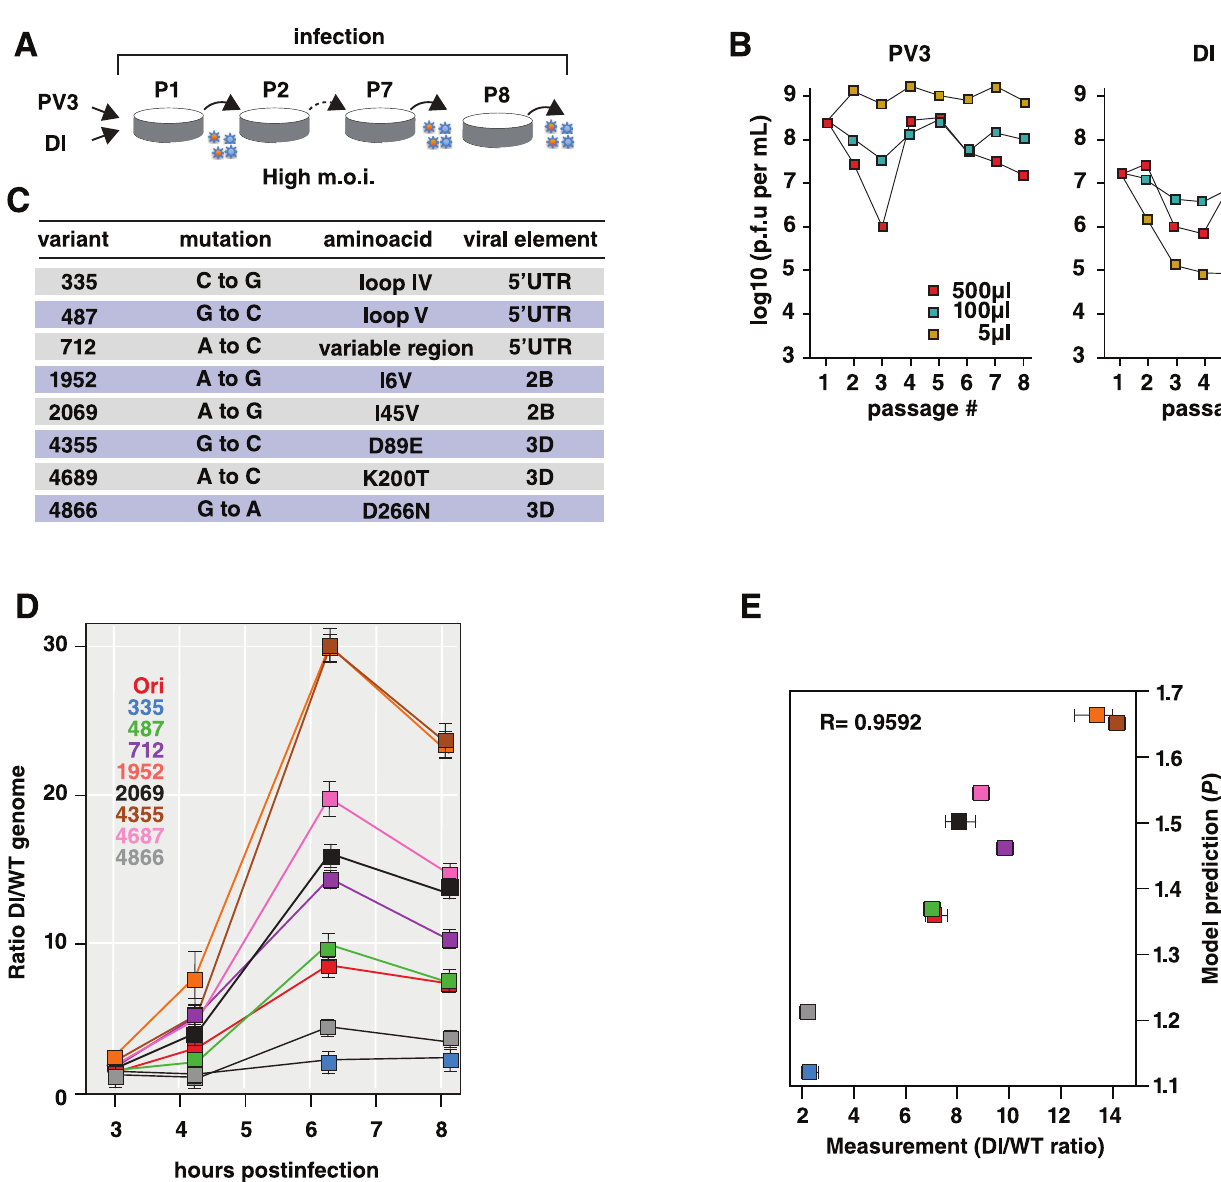
Fig 5. Investigating DI mutant genomes. A: PV3 and PV1-DI particles were serially passaged 8 times. B: Titers of PV3 (PFU/mL) and PV1-DI particles (IU/mL) included in the samples were determined. C: Mutations in the DI genomes positively selected over passages. D: One-step replication cycle. Dynamics of the ratio of PV1-DI to (wild-type) WT PV1 naked genome copies (total RNA) over time (3, 4.33, 6.33 and 8.17 hours post transfection), for distinct DI mutants (Ori: original non- mutant DI genome). E: Estimation of the ratio of PV1-DI to WT PV1 replication rate P from a least square regression between experimental and model predicted PV1-DI to WT PV1 naked genome ratios. Confidence intervals represent values of P at 10% of the minimum least square value. Model predictions of P against experimental DI to WT naked genome ratios at the last sampling time-point.